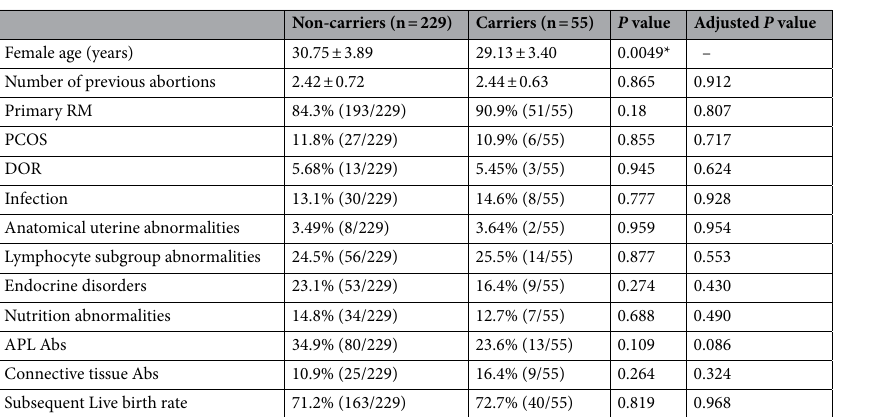
Table 1. Analysis of combined non-genetic etiological factors and live birth rate of 229 RM non-carriers and 55